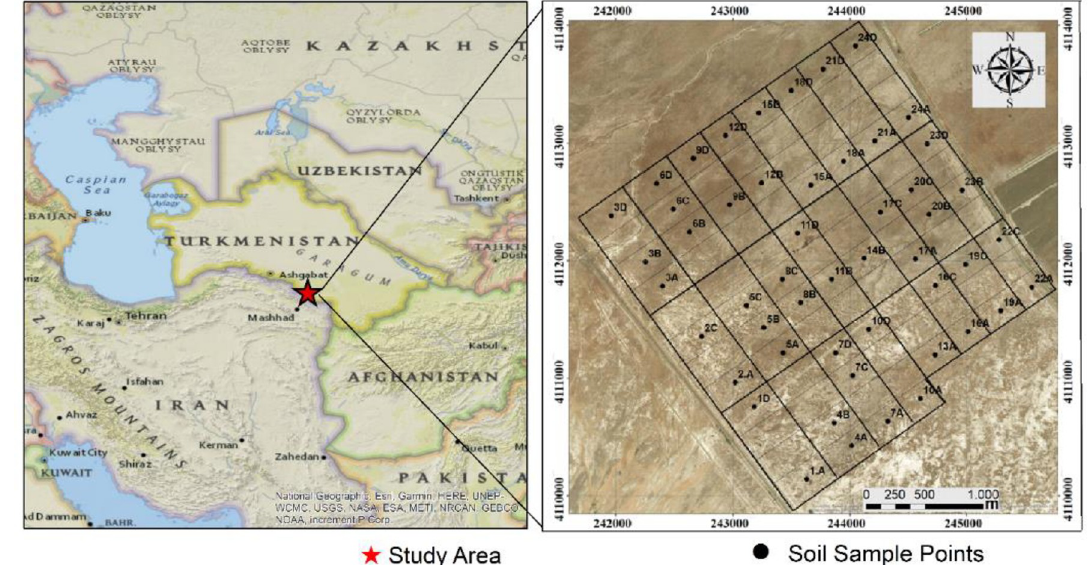
Fig 1. Location of study area and distribution of the sampling